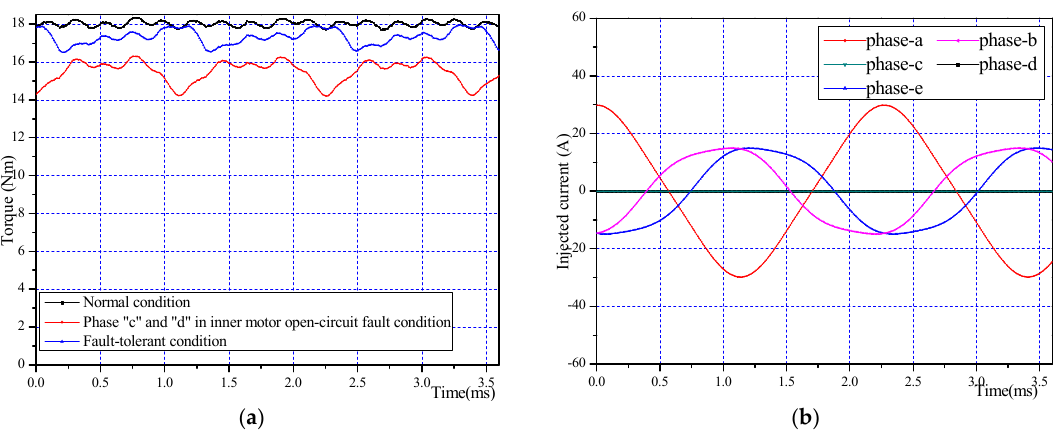
Figure 20. The motor operates under adjacent double ‐ phase open circuit in inner motor condition: ( a ) electromagnetic torque obtained by FEA; ( b ) the injected currents of inner motor.